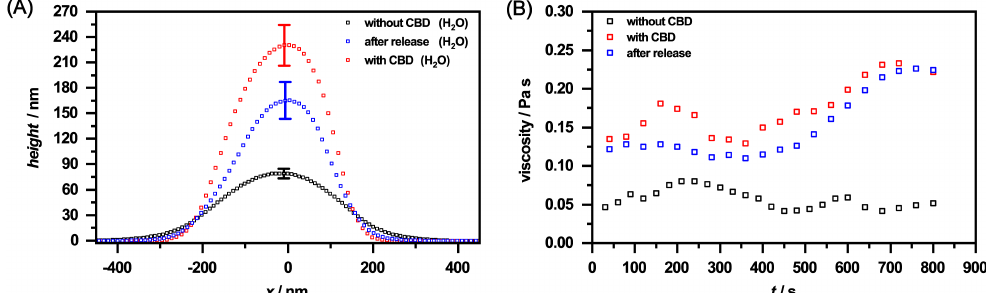
Figure 14. ( A ) Height profiles of the copolymer microgel particles in water (black), after loading with CBD (red) and after CBD release (blue), obtained by AFM measurements in the completely dry state after deposition of the copolymer microgel particles on a silicon surface. All height profiles were generated by averaging the individual height images of at least 30 particles from Figure A8. The error bar indicates the statistical uncertainty of the height. ( B ) Rheology measurements of the corresponding microgel particles at a constant shear rate of 0.5s − 1 and a duration of 800 s. The change in the viscosity of the different microgel solutions is shown as a function of time. The measurements were performed at a temperature of